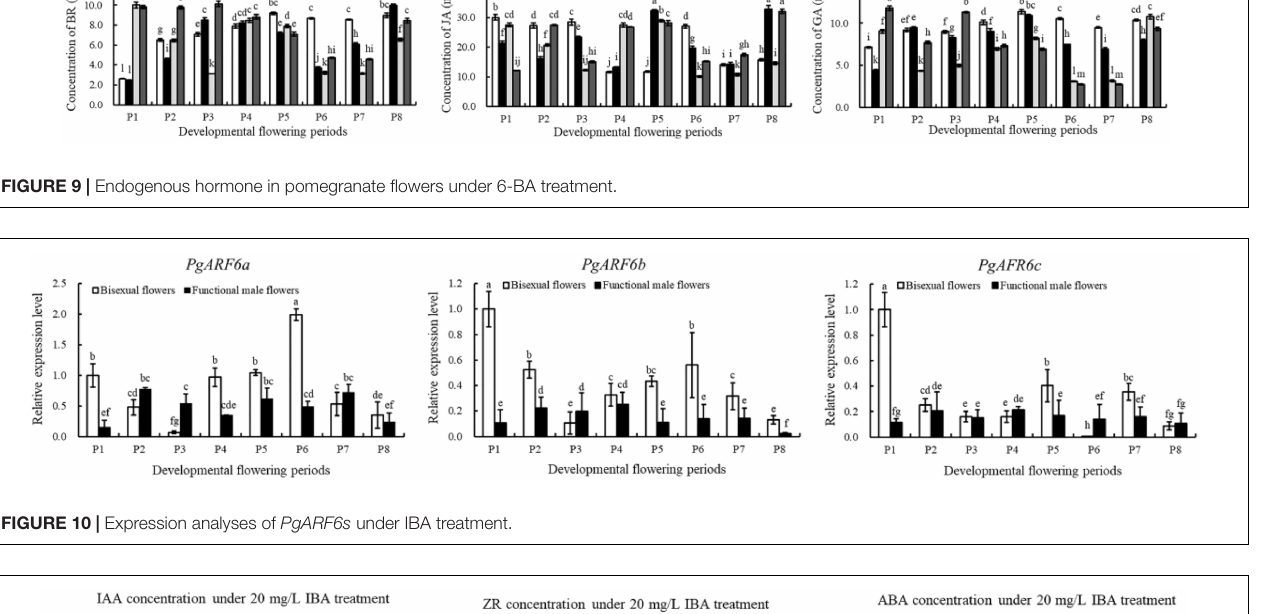
was lower compared with functional male flowers, except P8 ( Figure 11 ). During the bisexual flowers development, JA content in the treatment was lower than that in the control at P1–P2 and P4–P5 stages, whereas BR content in the treatment